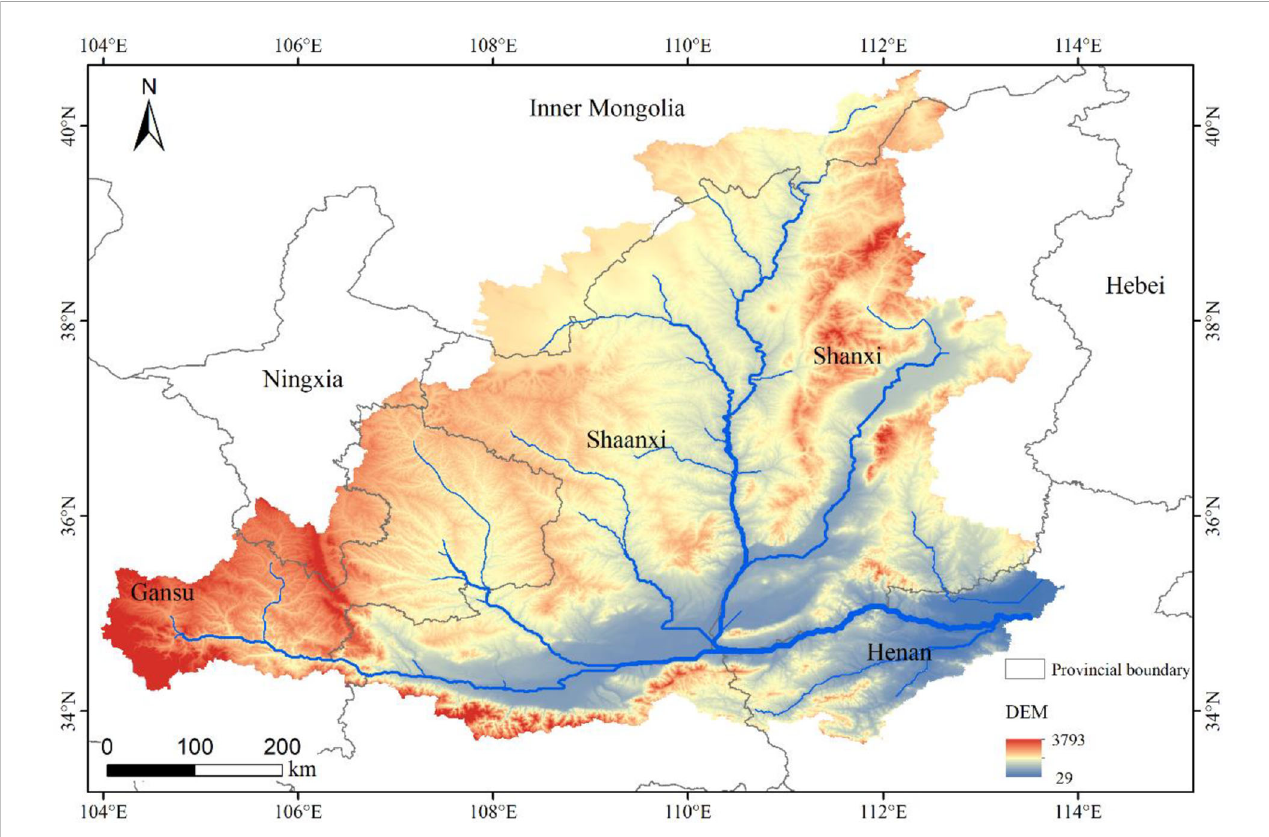
FIGURE 1 Location of the study